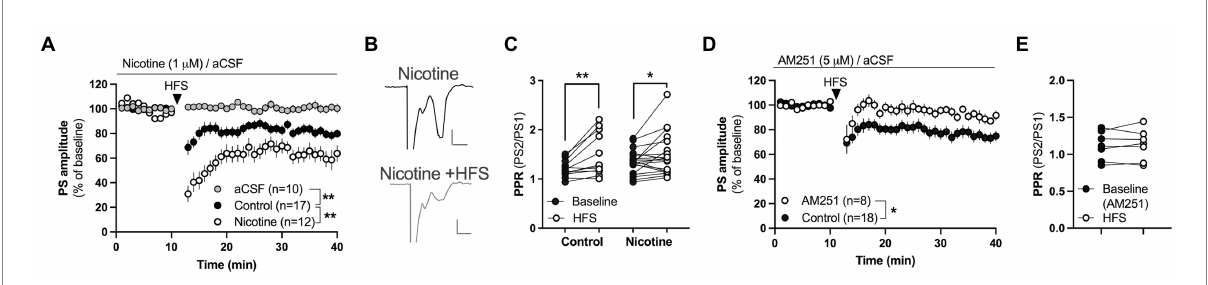
FIGURE 2 Nicotine facilitates endocannabinoid-mediated LTD in the DLS. (A) HFS produced LTD in both aCSF-treated control slices and in nicotine pre- treated slices, but synaptic depression was significantly enhanced by nicotine. (B) Example traces showing evoked potentials at nicotine-treated baseline (upper trace) and 25 min after HFS (lower trace). Calibration: 0.2 mV, 2 ms. (C) HFS increased PPR in both aCSF-treated control slices and slices treated with nicotine, indicating that HFS decreases the probability of transmitter release. (D,E) HFS did not induce LTD in brain slices-pre- treated with AM251. Data are mean values ± SEM. n = number of slices, taken from at least three animals. * p < 0.05, ** p <